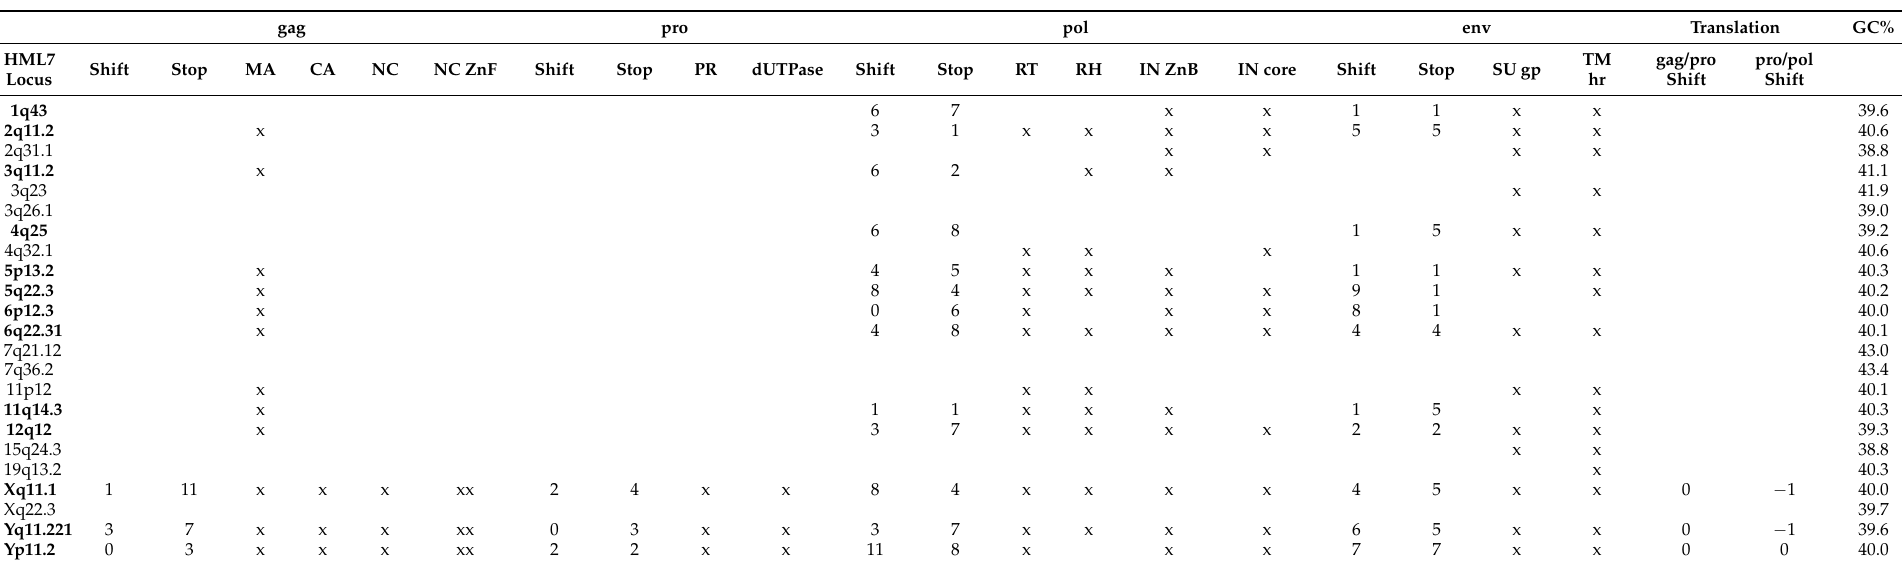
Table 3. Coding potential and functional domain predicted for the HML7 proviral